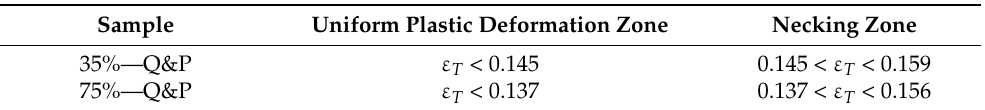
Figure 8. ( a ) True stress–strain plots and ( b ) strain−hardening rate plots of 35%−Q&P sample and 75%−Q&P sample. Table 2. The true strain ( ε T ) ranges of uniform plastic deformation zone and necking zone of 35%−Q&P sample and 75%−Q&P sample.